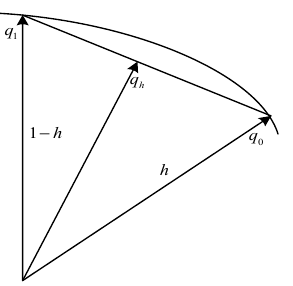
interval [0, 1], the interpolation segments obtained are not uniformly distributed, i.e., linear interpolation only has formally "linear interpolation". Slerp , i.e., spherical linear interpolation, which is linear interpolation on the sphere, which is a linear interpolation of angles, i.e.,